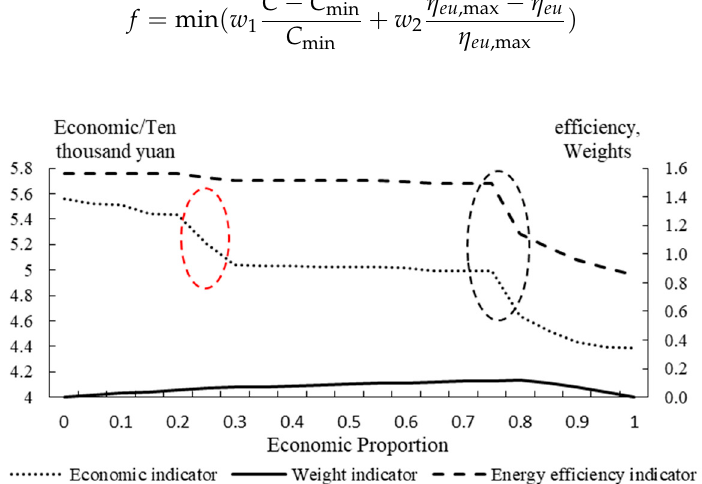
Figure 19. Optimization target values under different weights.